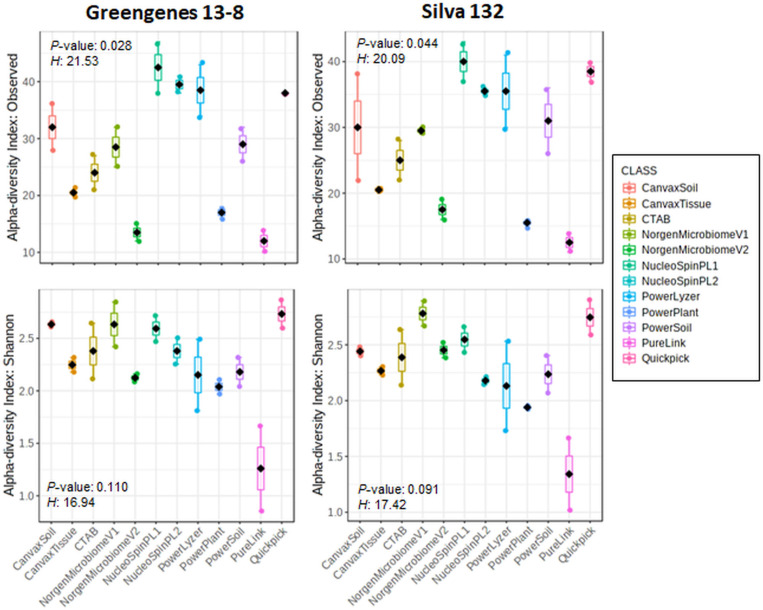
Boxplots of Richness and Shannon alpha diversity indices of olive xylem bacterial communities at operational taxonomic unit (OTU) taxonomic level determined by different DNA extraction kits and after taxonomic assignments with the Greengenes_13-8 and Silva_132 databases. Boxes represent the interquartile range, while the black dots inside the box define the median, and whiskers represent the lowest and highest values. P value was calculated using Kruskal–Wallis test.